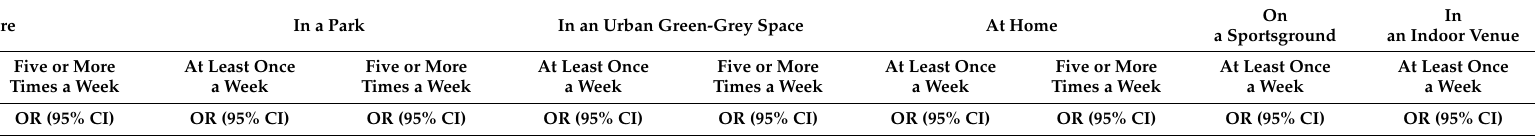
Table 5. Association between Living Environment Characteristics and Physical Activity